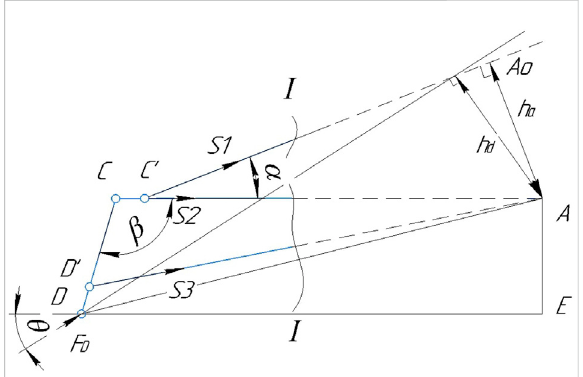
FIGURE 7 Design diagram of the left part of the suspension lever